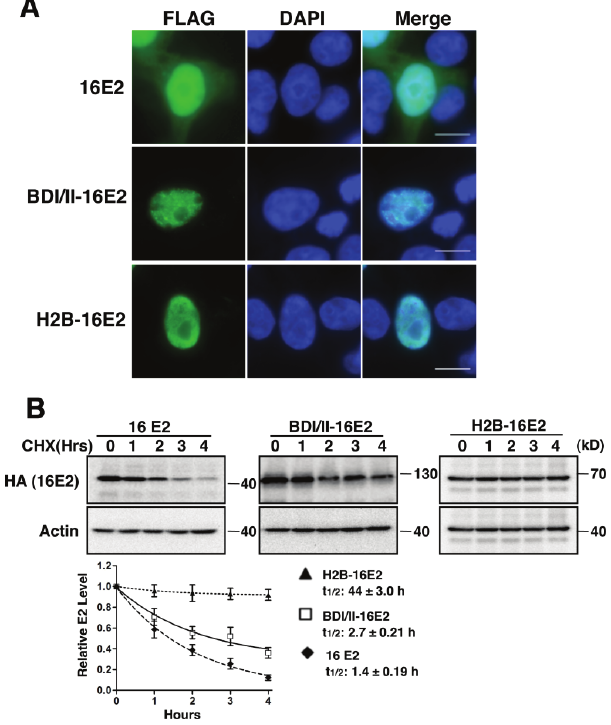
Figure 5. Tethering of HPV16 E2 to host chromatin increases E2 stability. ( A ) 293T cells were transfected with pOZN-16E2, pOZN-BDI/II-16E2, or pOZN-H2B-16E2. Transfected cells were stained with FLAG antibody (green) for 16E2 and counterstained with DAPI. Bar, 5 μ M; ( B ) HEK293T cells were transfected with pOZN-16E2, pOZN-BDI/II-16E2 or pOZN-H2B-16E2. Cells were treated with 100 μ g/mL cycloheximide (CHX) at 24 h after transfection for the lengths of time indicated. Cell lysates were harvested and analyzed by Western blotting using HA (16E2) and actin antibodies. Representative blots are shown. Protein bands from the immunoblots were quantitated with Image J, using the actin signal for normalization. Relative E2 level and half-lives were calculated and presented, as in Figure 3A. This experiment was performed three times with similar results.